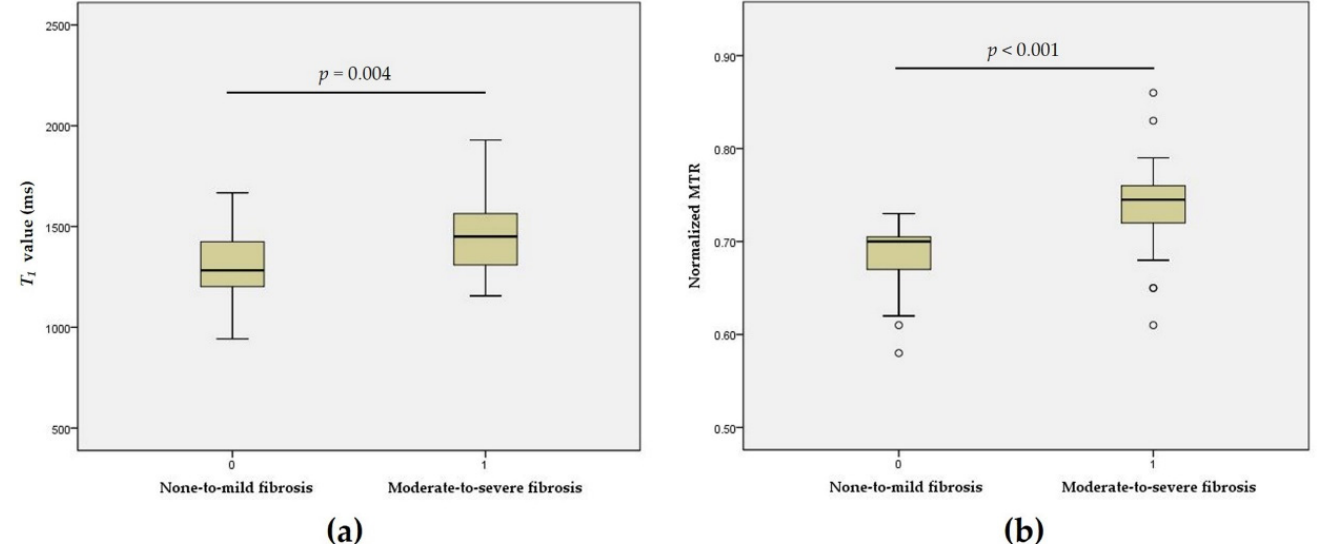
Figure 2. Boxplots showing differences in the T 1 value and normalized MTR between none-to-mild and moderate-to-severe fibrosis. Significant differences in T 1 values ( t = − 3.066, p = 0.004) ( a ) and normalized MTR ( z = 5.081, p < 0.001) ( b ) were found between the none-to-mild and moderate-to-severe fibrosis groups. MTR = magnetization transfer ratio; T 1 = longitudinal relaxation time.